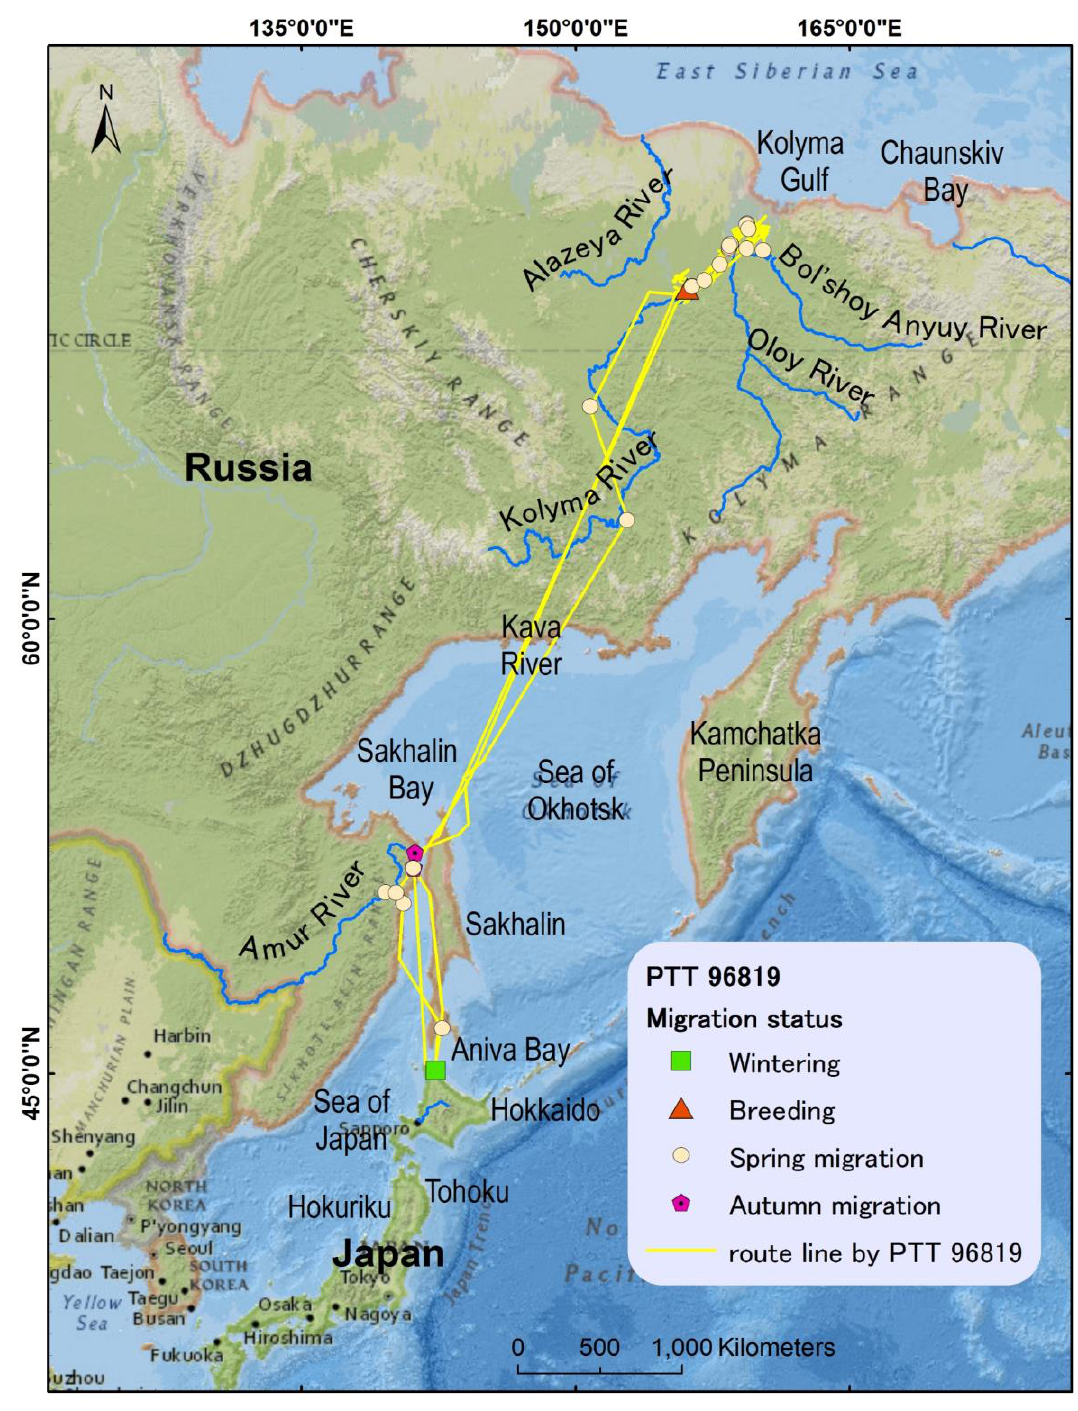
Figure 8. Classified migration status on the map